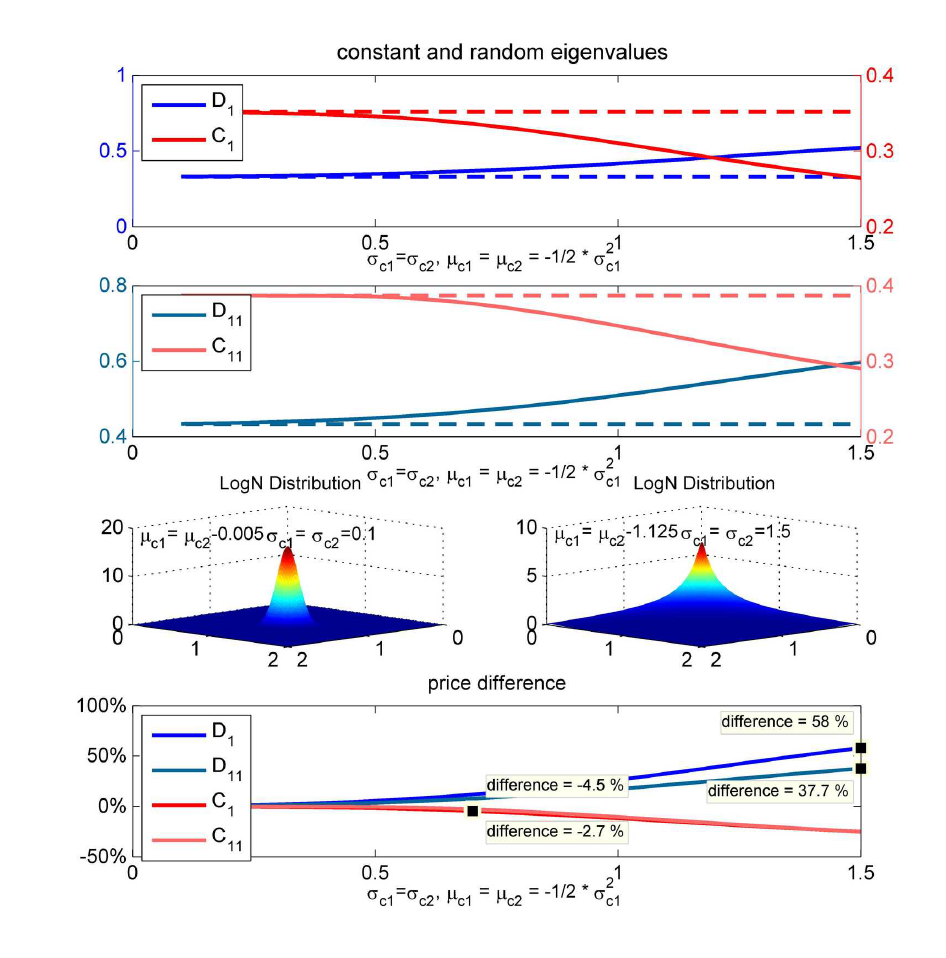
Figure 11. Effect of increasing uncertainty about both eigenvalues ( k = 2) and price differences between random and constant